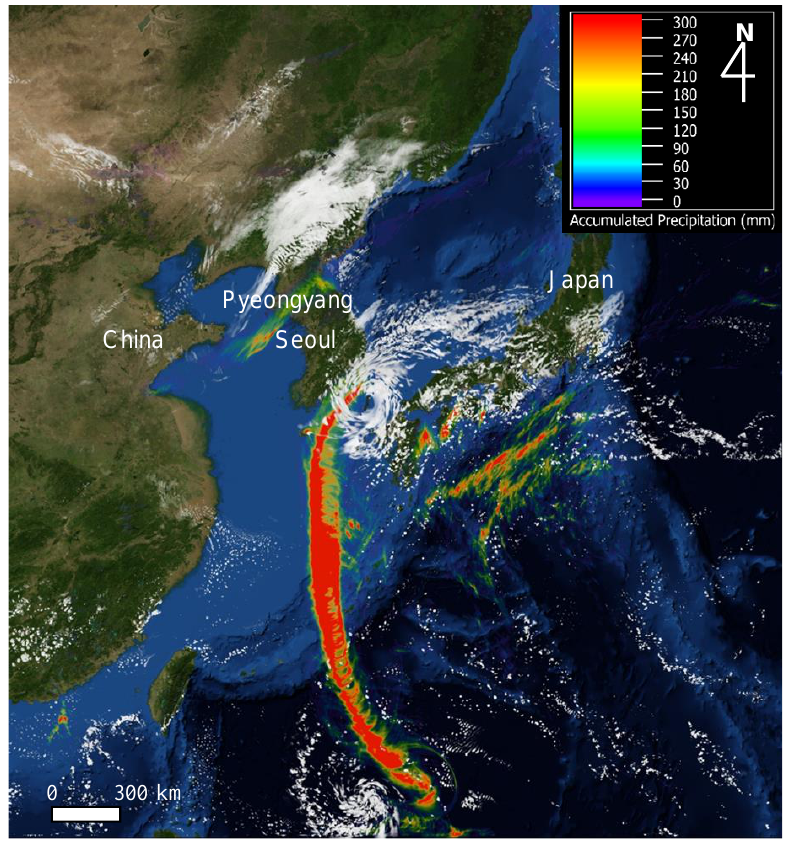
Figure 6. Visualization of cloud and accumulated precipitation of the typhoon .